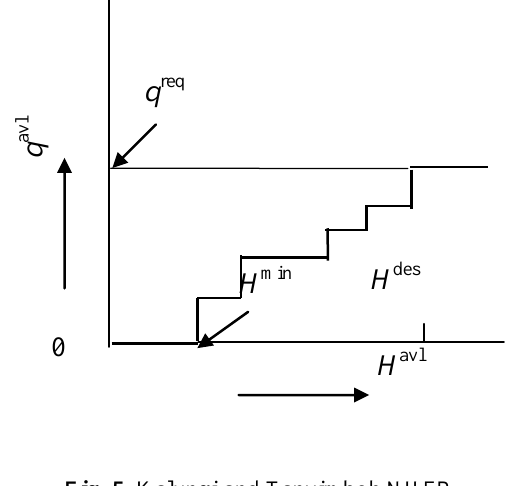
Fig. 5. Kalungi and Tanyimboh